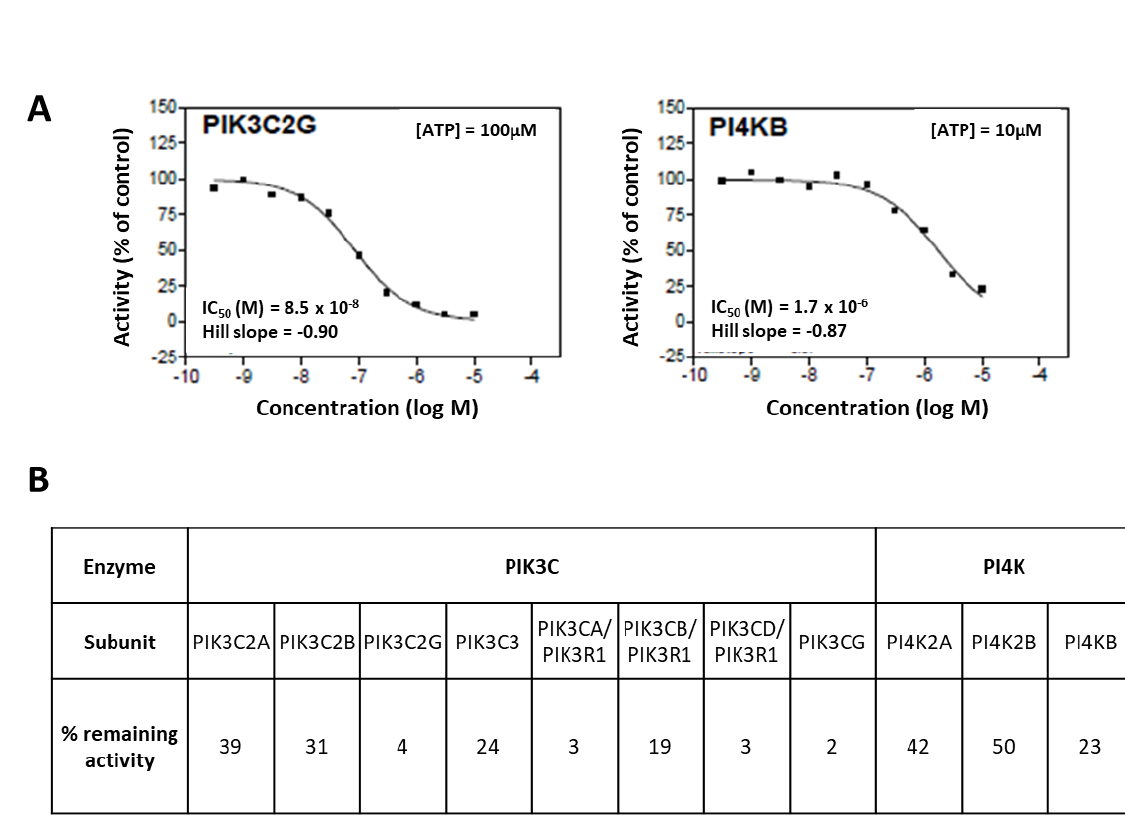
Figure 1: MV652103 potently inhibits PI4KB and PIK3C2G lipid kinase activity. ( A ) IC 50 curves of MMV652103 from the diaryl-imidazopyridazine (SFK52) series in 2 lipid kinase assays, PIK3C2G and PI4KB. ( B ) Table showing the percentage remaining activity of PI4KB and PIK3C2G, and their respective subunits, after treatment with MMV652103 from the diaryl-imidazopyridazine (SFK52) series at a concentration of 10 µM. The IC 50 values were measured by testing 10 semi-log concentrations of the compound in singlicate in each kinase assay, ranging from 1 x 10 -5 M to 3 x 10 -10